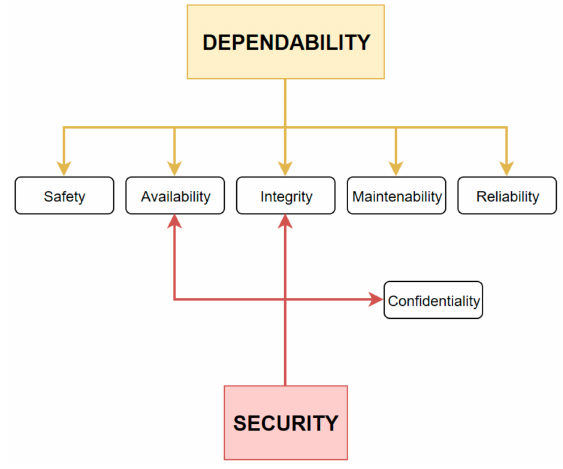
Figure 5. Hook-up dependability and